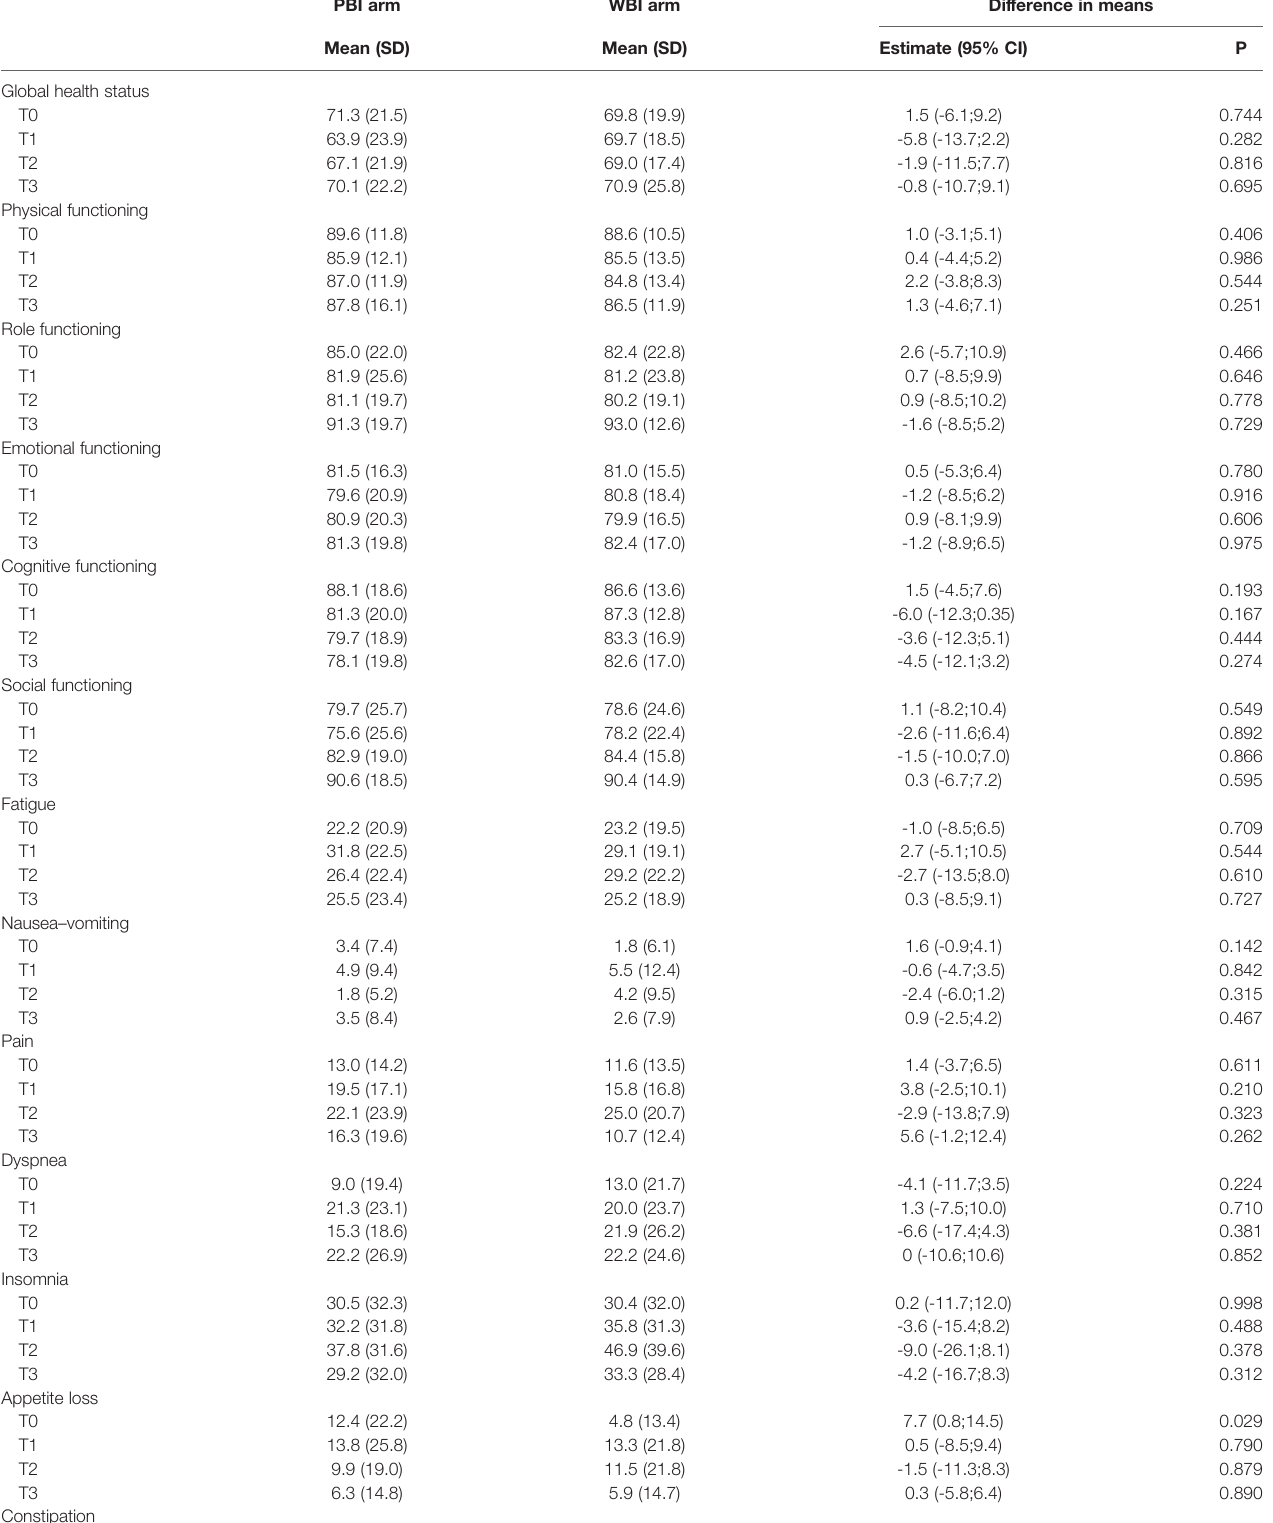
TABLE 2 | Mean scores (and SD) of EORTC QLQ-C30 at T0, T1, T2, and T3 between the two arms. PBI arm WBI arm Difference in means Mean (SD) Mean (SD) Estimate (95% CI)